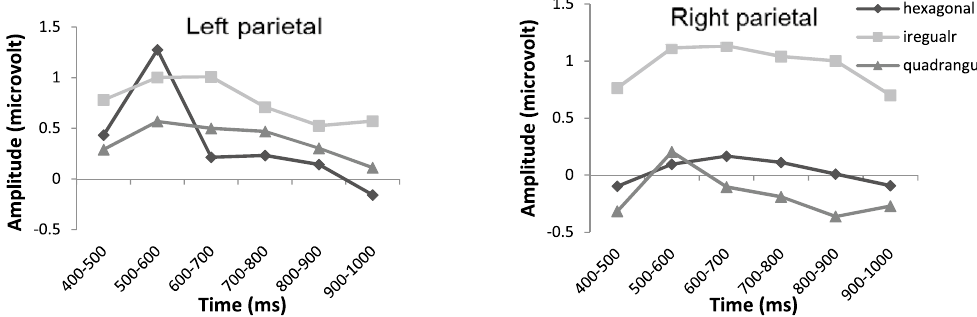
magnitude in two parietals (left: left parietal; right: right parietal). Here magnitude is shown as the difference between smallest (8) and largest (12) magnitude